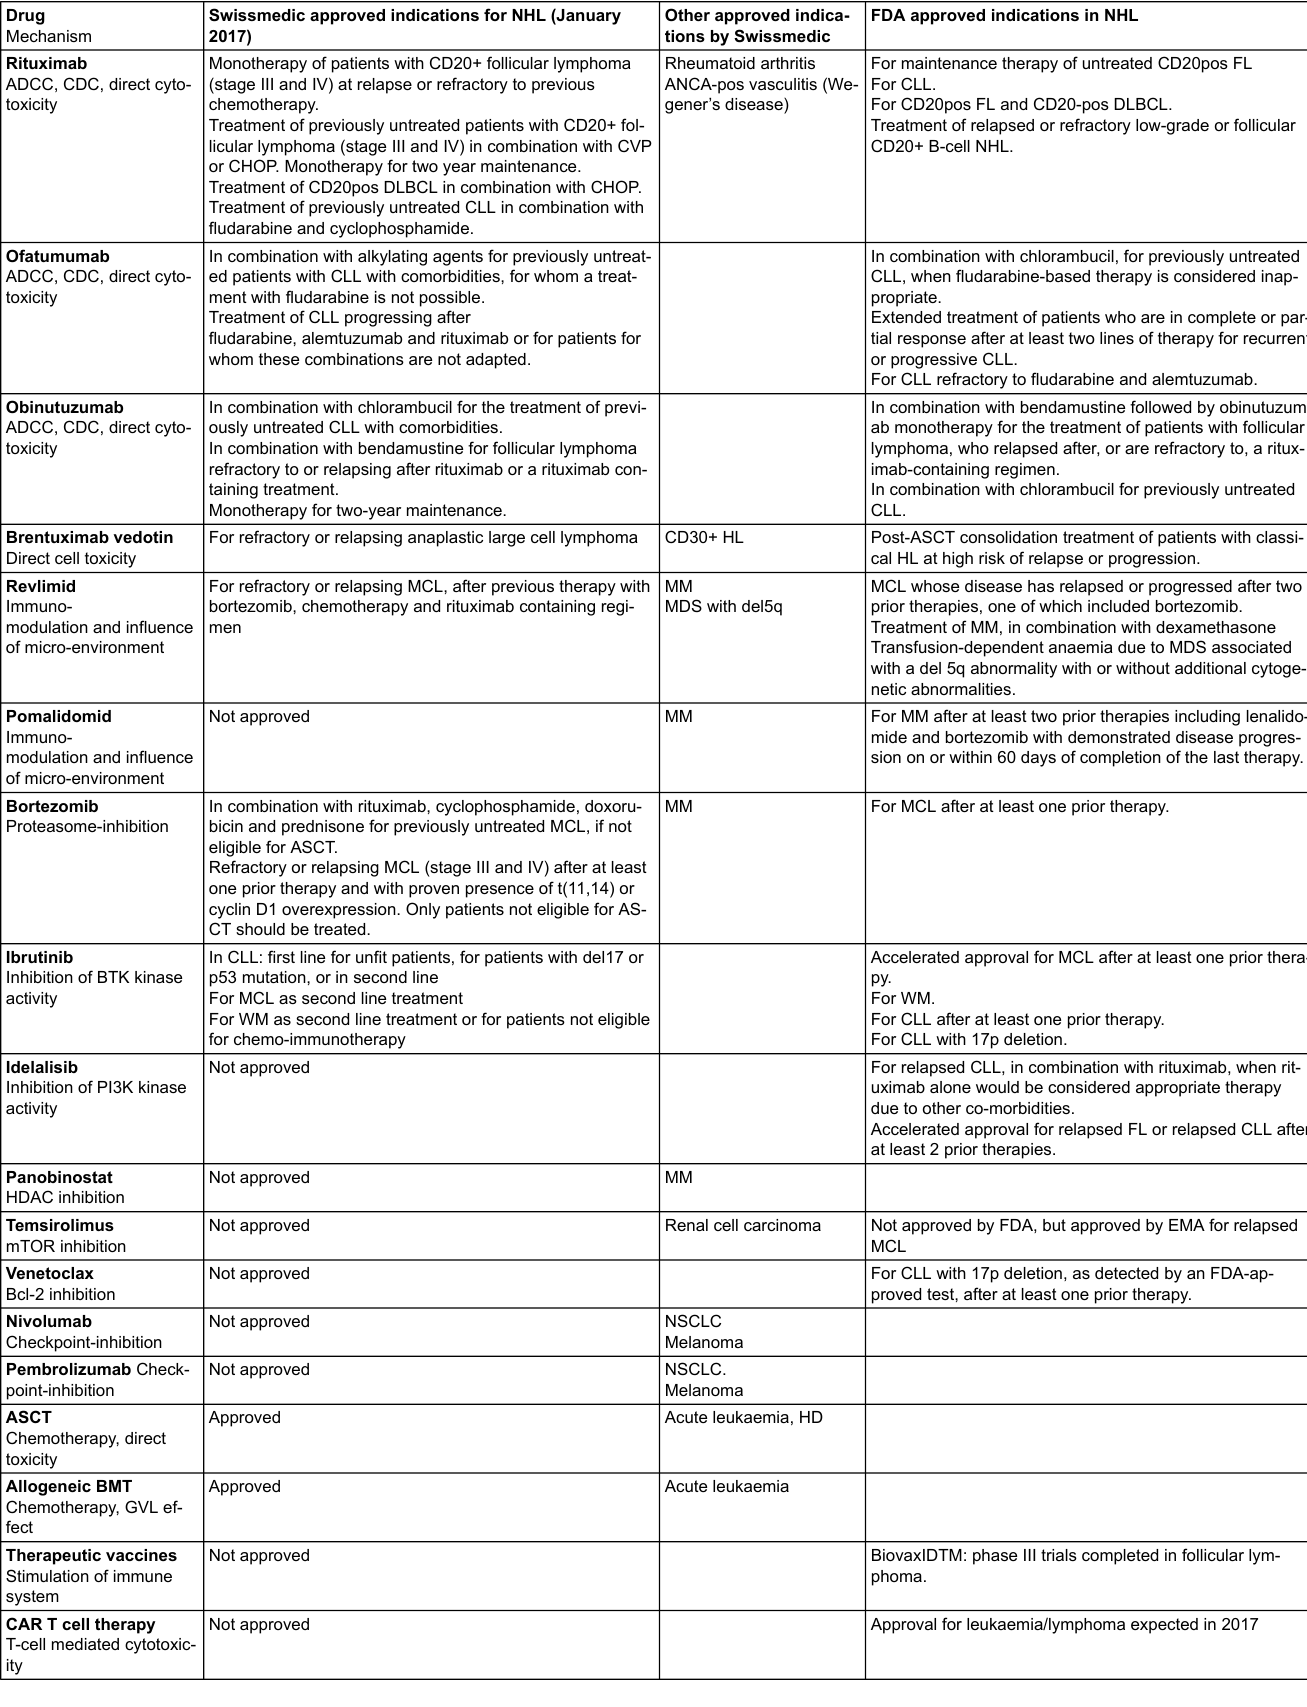
Table 1: Drugs used for the treatment of non-Hodgkin B cell lymphomas. Drug